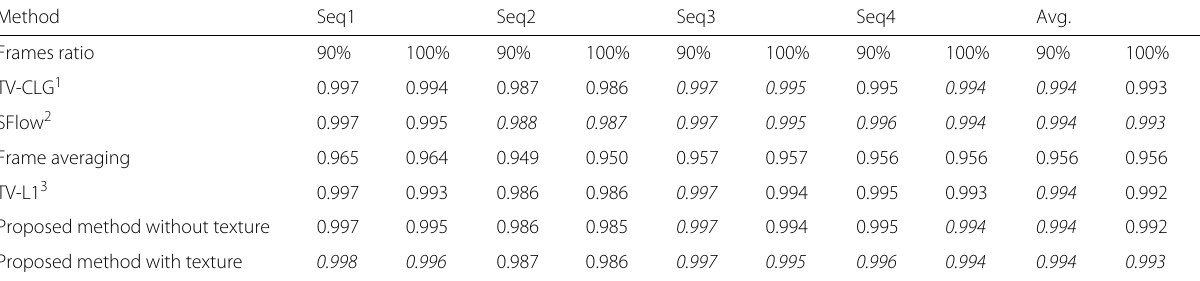
Table 3 Average SSIM for 90 and 100% of test sequences Method Seq1 Avg. Frames